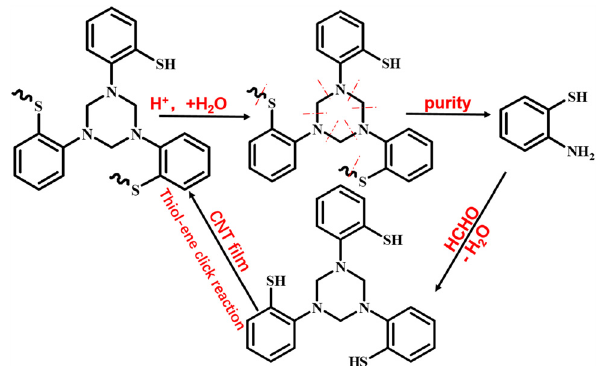
Figure 11: The mechanism of preparation and degradation cycle of nitrogen - doped CNT fi lm functionalized by hexahydro - s -